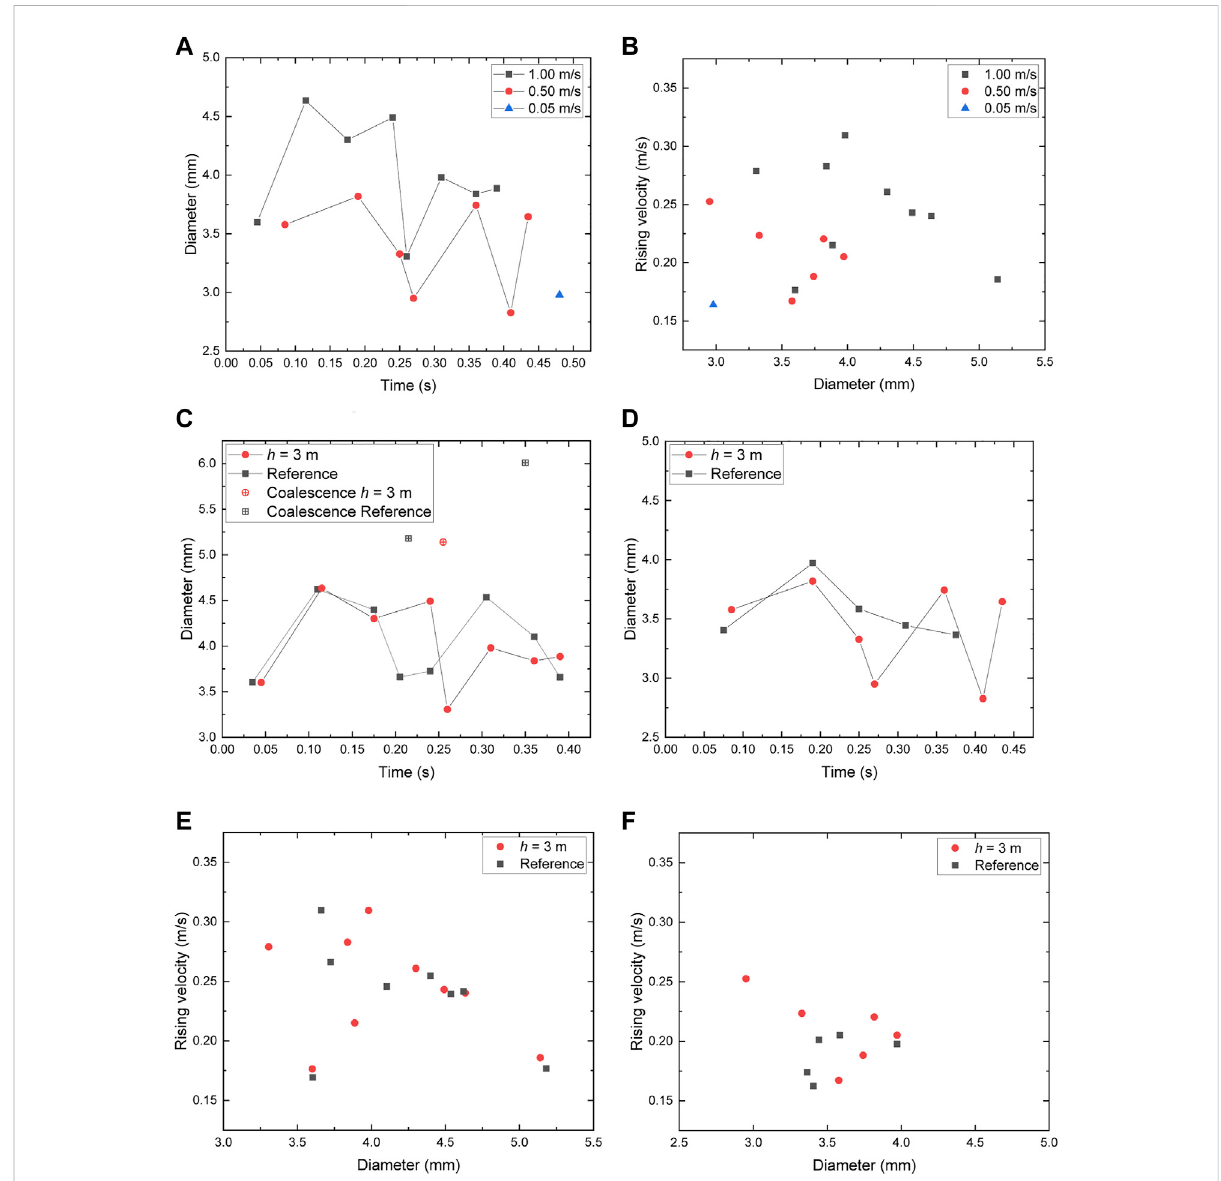
FIGURE 10 In fl uence of release depth on the release and migration behavior of bubbles in molten LBE. (A) Equivalent diameter. (B) Terminal rising velocity. (C) Equivalent diameter,